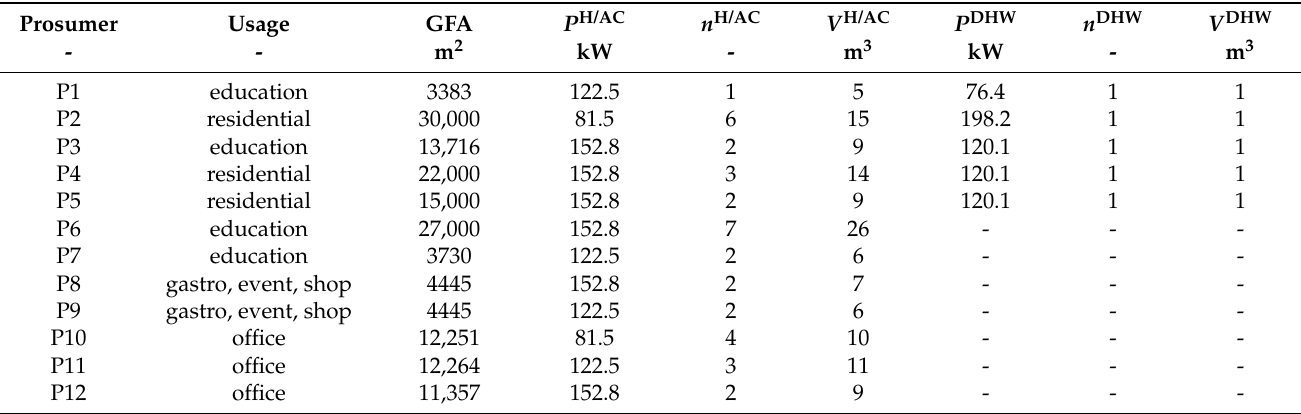
Table 2. Categorisation of prosumers and equipment of ETS: Gross floor area, capacity and number of heat pumps for H/AC and DHW, volume of short term water